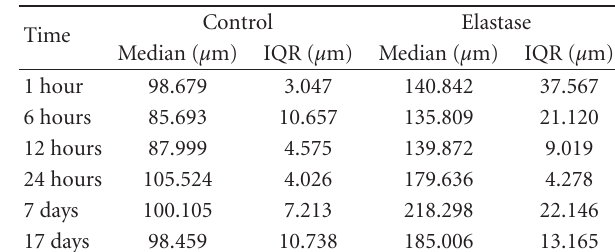
Table 5: Evolution of D 2 at the experiment time points after elastase